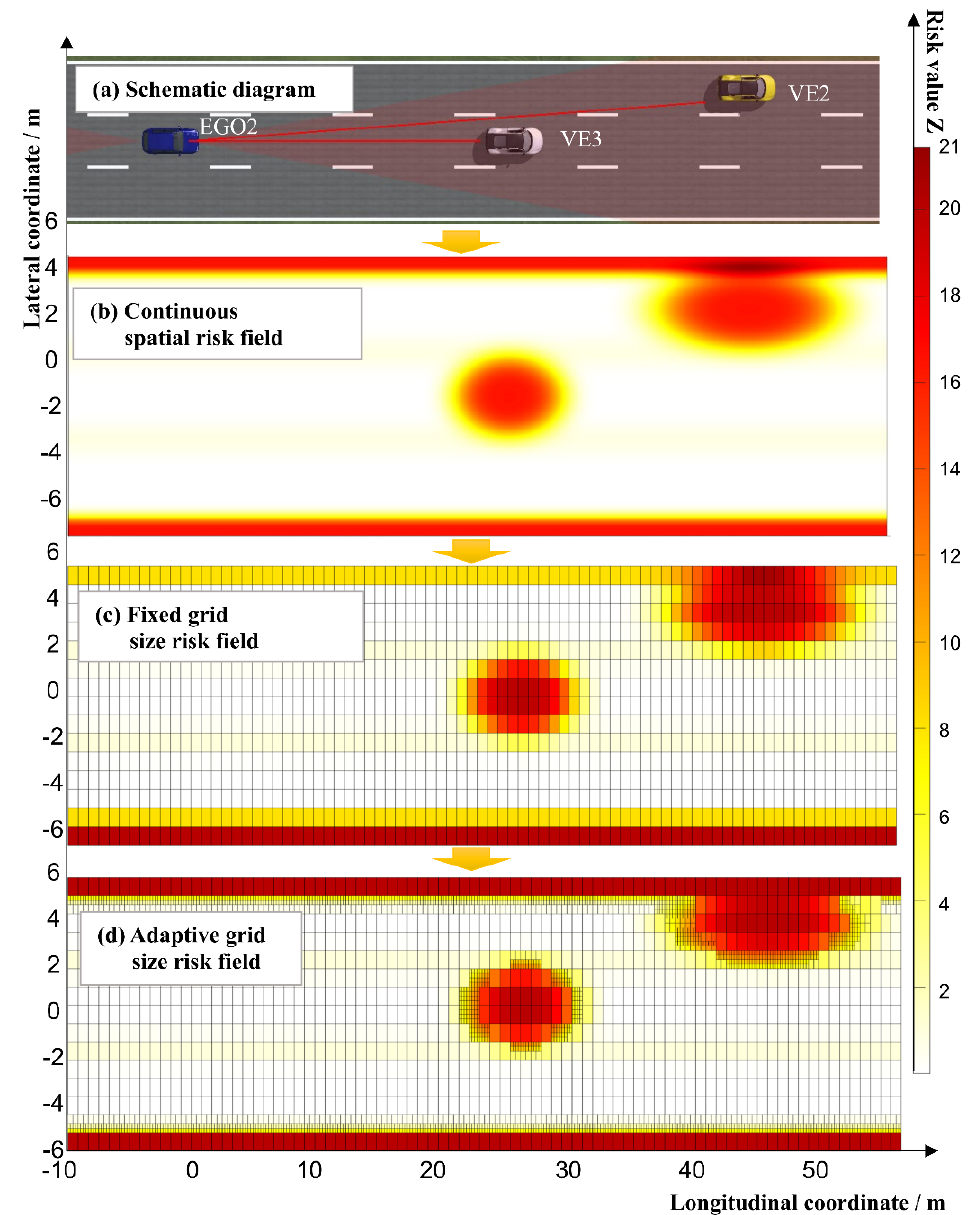
Figure 15. Adaptive grid-based risk-field generation for actual vehicle scenario: ( a ) schematic diagram of the actual vehicle scenario; ( b )continuous spatial risk-field; ( c ) fixed grid size risk field; ( d ) Adaptive grid size risk field;